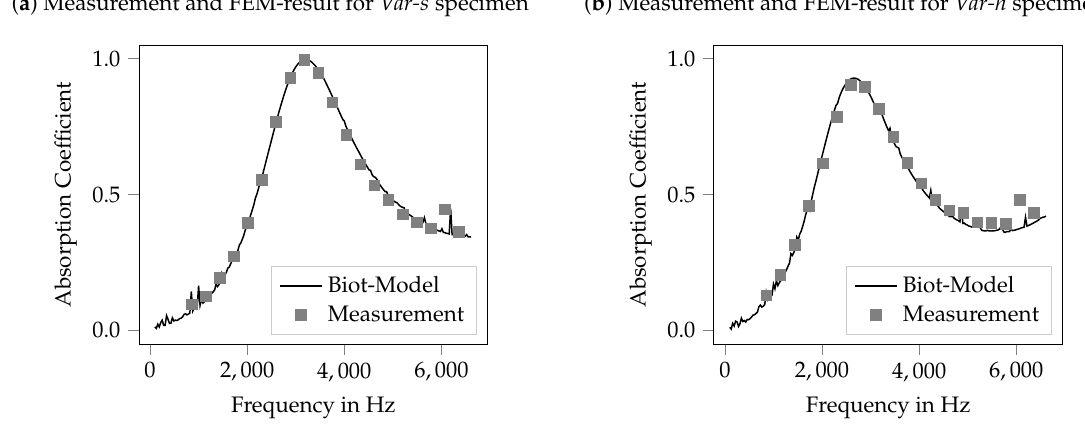
( a ) Measurement and FEM-result for Var-s specimen ( b ) Measurement and FEM-result for Var-h specimen